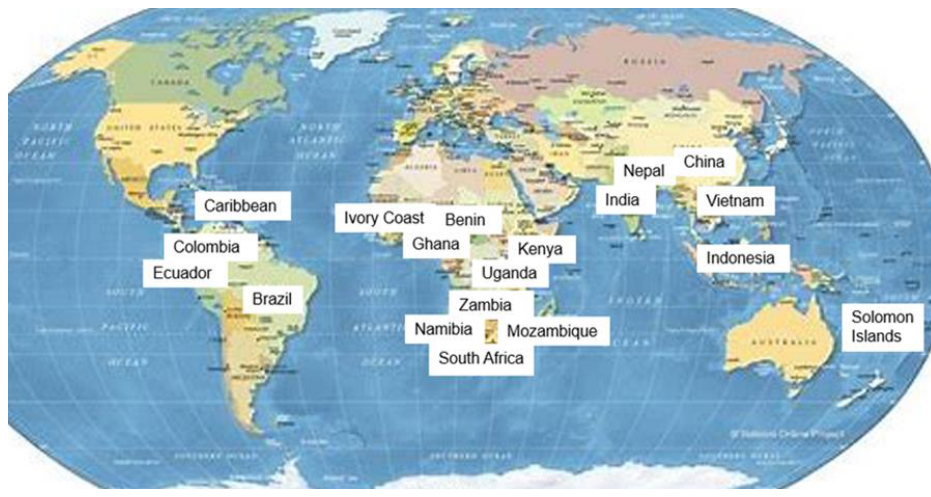
Figure 2. FFPLA Country assessments and implementations addressed in this Special Issue.